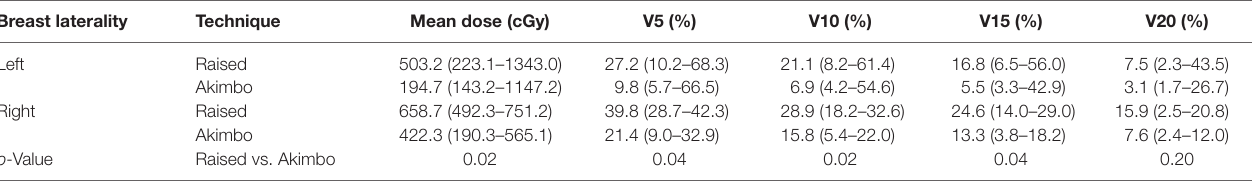
TaBle 3 | Breast dosimetry in relation to arm